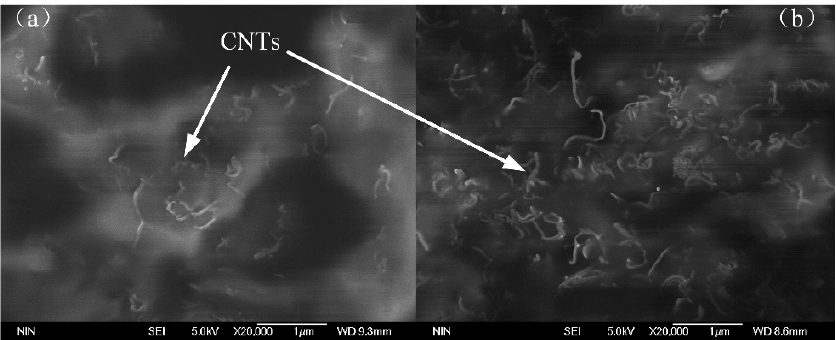
Figure 3. ( a ) Scanning Electron Microscope (SEM) images of the composite with 5 wt% MWCNTs content; ( b ) SEM images of the composite with 6 wt% MWCNTs content.